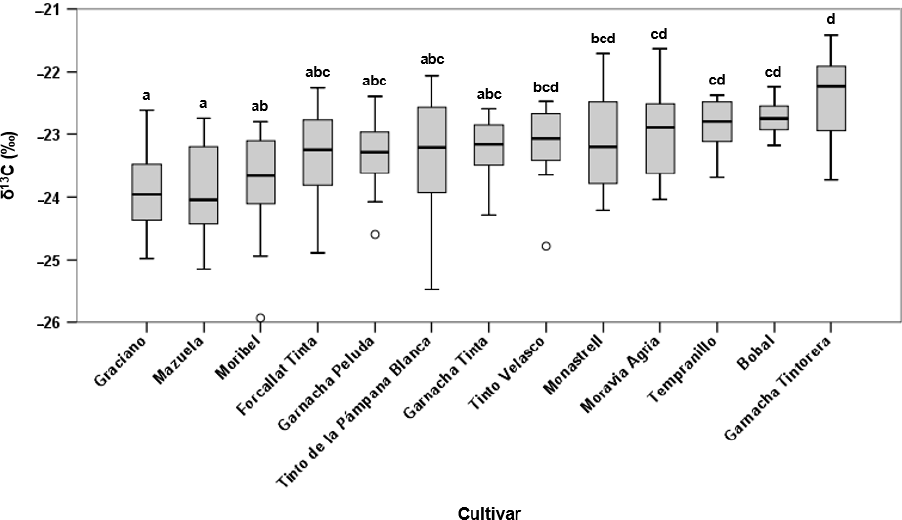
13 C) in grape must at harvest time. The box plot illustrates the New Figure 6: Figure 3. Carbon isotope ratio ( δ distribution of δ 13 C values of must from 13 red cultivars from 2018 to 2020. The results are ordered by their means. The black solid line indicates that the median and the box ends correspond to the 25th and 75th percentiles of the data. The error bars represent the 10th and 90th percentiles. The mean δ 13 C values of cultivars with different letters (a, b, c, and d) are significantly different at p < 0.001 as indicated by the S–N–K test. The hollow circles outside the boxes correspond to